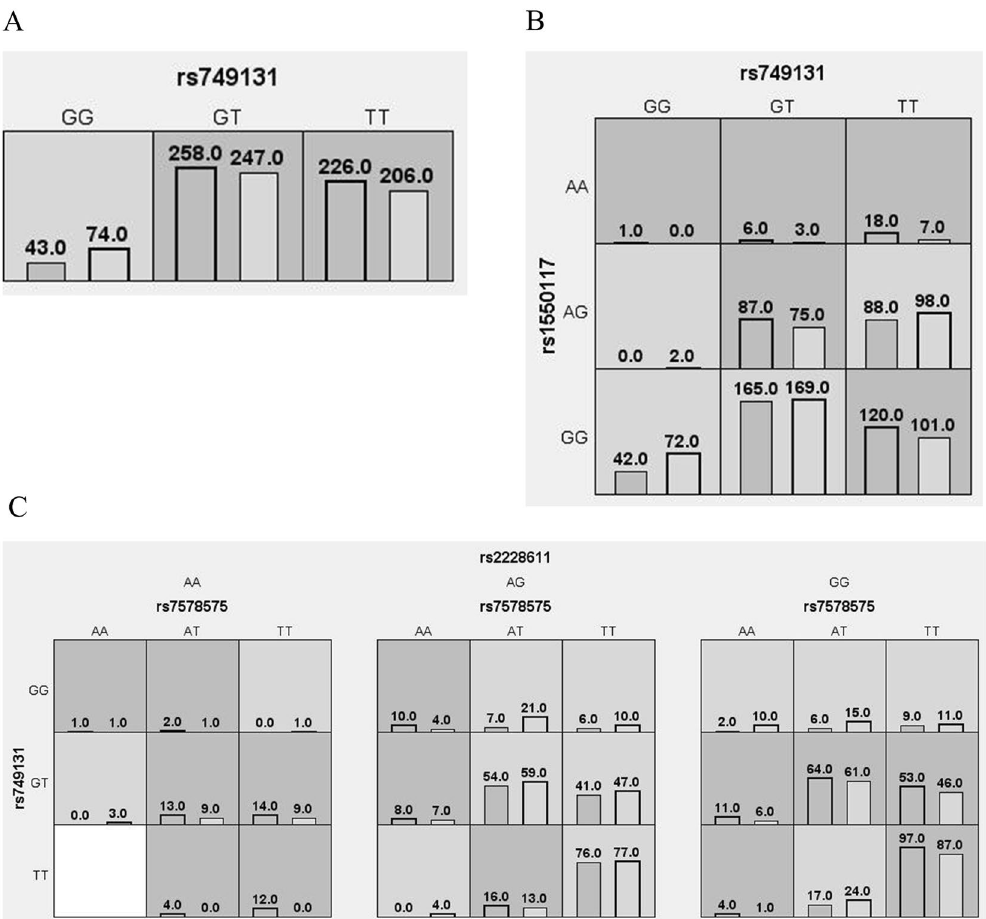
Figure 2. Graph model of the interaction between the four SNPs. Dark gray and light gray boxes presented the high- and low-risk factor combinations, respectively. Left bars within each box represented case while the right bars represented control. The heights of the bars are proportional to the sum of samples in each group.